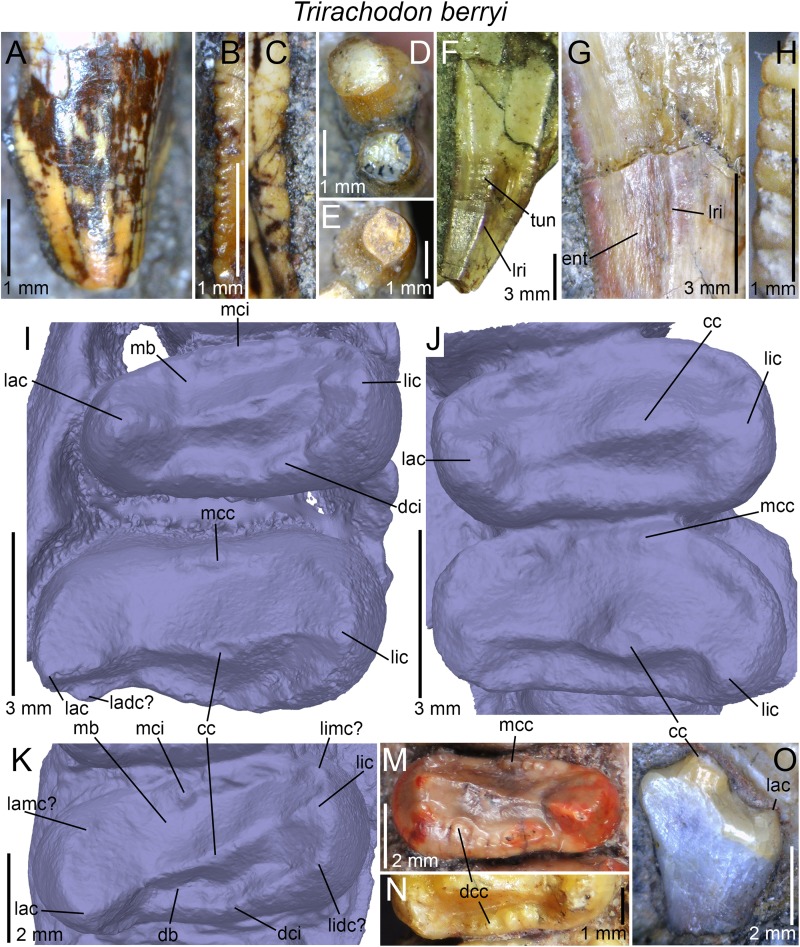
Dentition of Trirachodon berryi.(A–C) First? left upper incisor, with close up on (B) mesial and (C) distal denticles of SAM-PK-12168 in labial view; (D) first left and right upper and (E) first right lower incisors of BP/1/4658 in apical views; (F and G) right upper canine of BP/1/4661 with (G) close up on the centrodistal part of the crown, in labial view; (H) distal denticles of the right lower canine of BP/1/4658 in labial view; (I) fifth and sixth right upper gomphodont postcanines of SAM-PK-K171 (“T. kannemeyeri” morphotype) in apical view; (J) 10th and 11th left (reversed) upper gomphodont postcanines of BSP 1934 VIII 21 (T. berryi morphotype) in apical view; (K) penultimate right upper gomphodont postcanine of SAM-PK-K4801 (“T. kannemeyeri” morphotype) in apical view; (M) penultimate left upper gomphodont postcanine of NHMUK PV R3307 (“T. kannemeyeri” morphotype) in apical view; (N) 10th left upper gomphodont postcanine of BSP 1934 VIII 21 (T. berryi morphotype) in apical view; (O) partially erupted twelfth (and last) upper gomphodont postcanine of BSP 1934 VIII 21 in distal view. Abbreviations: cc, central cusp; db, distal basin; dcc, distal cingular cuspule; dci, distal cingulum; ent, enamel surface texture; lac, labial cusp; ladc, labiodistal accessory cusp; lamc, labiomesial accessory cusp; lic, lingual cusp; lidc, linguodistal accessory cusp; limc, linguomesial accessory cusp; lri, longitudinal ridge; mb, mesial basin; mcc, mesial cingular cuspule; mci, mesial cingulum; tun, transverse undulation.